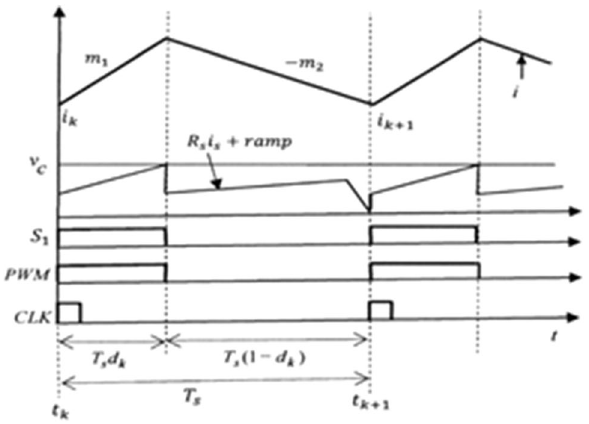
Figure 2. Key typical waveforms of Fig.